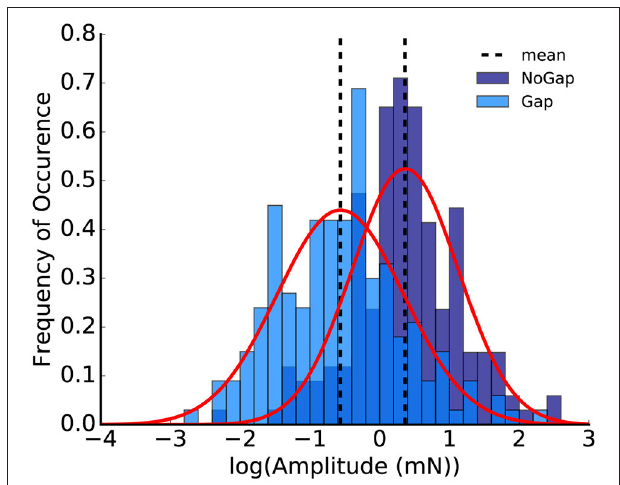
FIGURE 3 | Histogram of the logarithmized peak-to-peak amplitudes; the plot shows the animal replot of the data from Figure 1E. Shapiro-Wilk-test for normality emphasizes that the logarithmized amplitudes are Gaussian-like distributed ( p = 0.11 for no-gap and p = 0.21 for gap, normalized probability